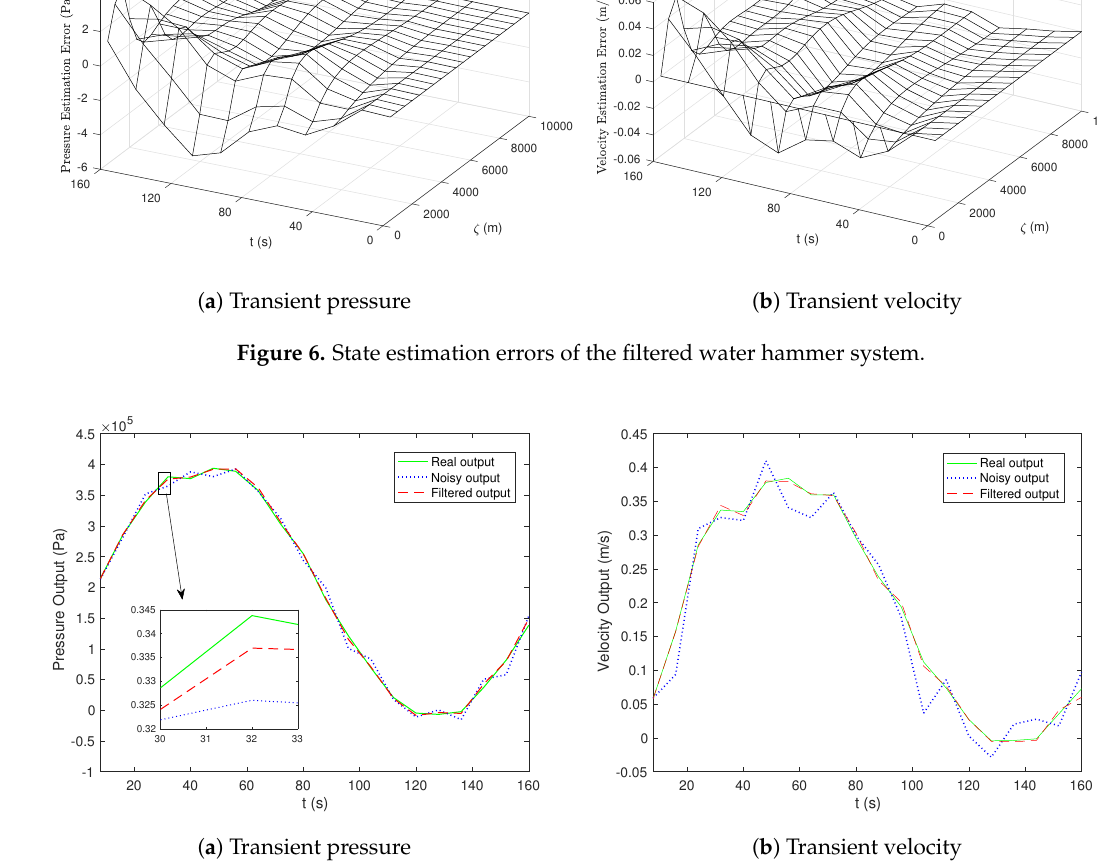
Figure 7. Profiles of the filtered output of the water hammer